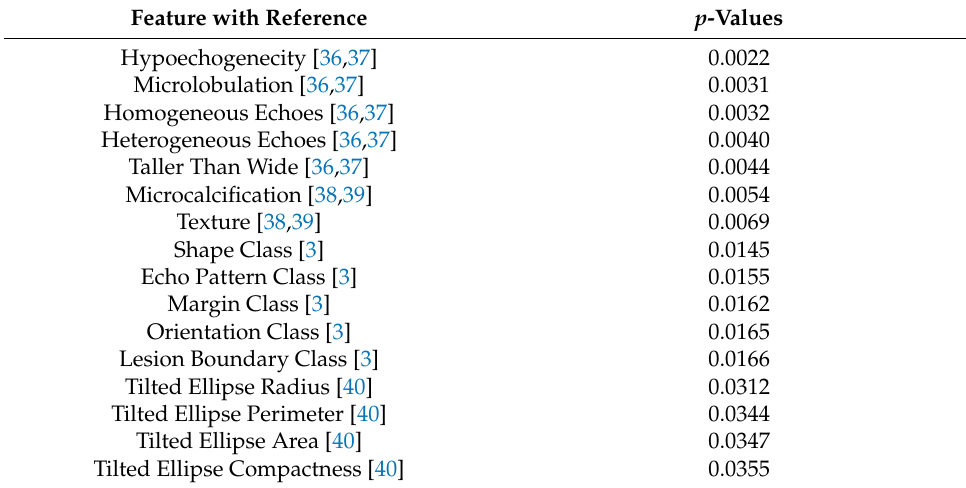
Table 4. The features utilization considering WCP images with ANOVA p